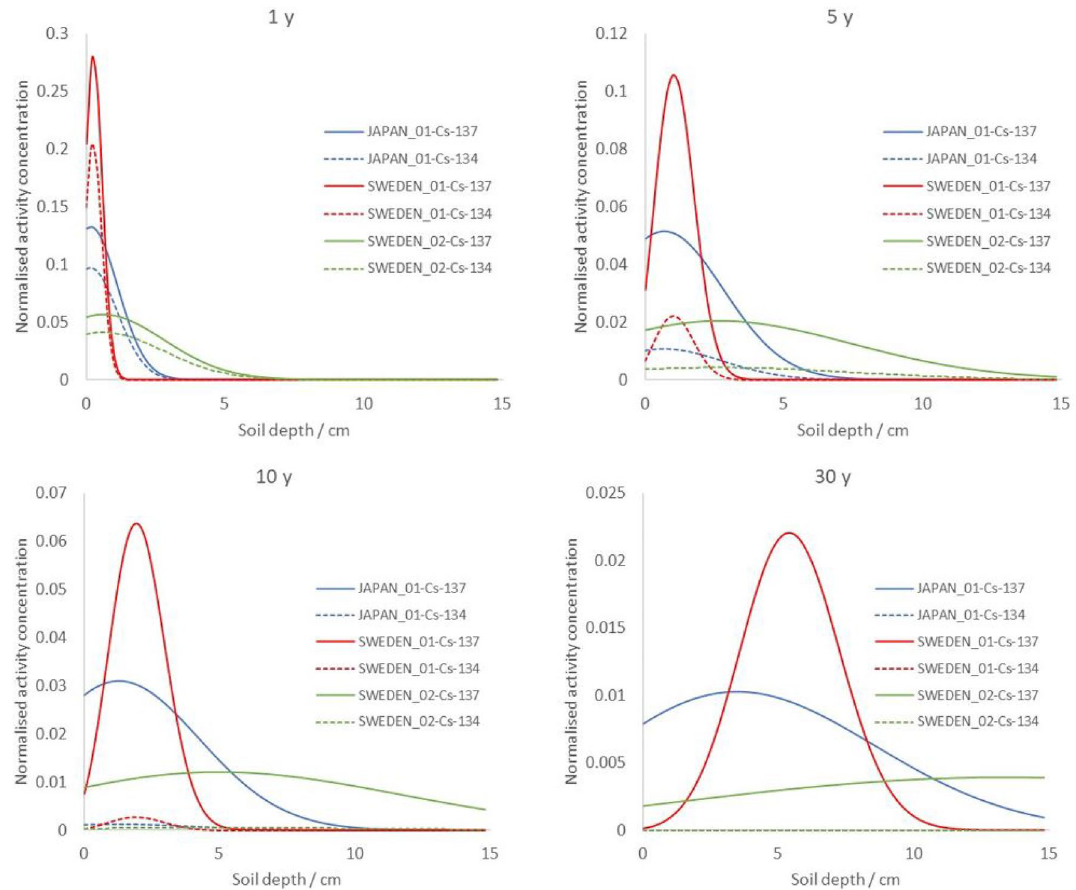
Figure 3. Soil depth profile for 137 Cs and 134 Cs (with initial 134 Cs: 137 Cs ratio of 1) for three different settings of vertical soil migration parameters after 1 y (top left), 5 y (top right), 10 y (bottom left), and 30 y (bottom right) after fallout (see also Table 2). The profiles are calculated for a soil with a density of 1.5 g cm −3 , and are normalized to the cumulative soil concentration at t = 0 for the respective Cs